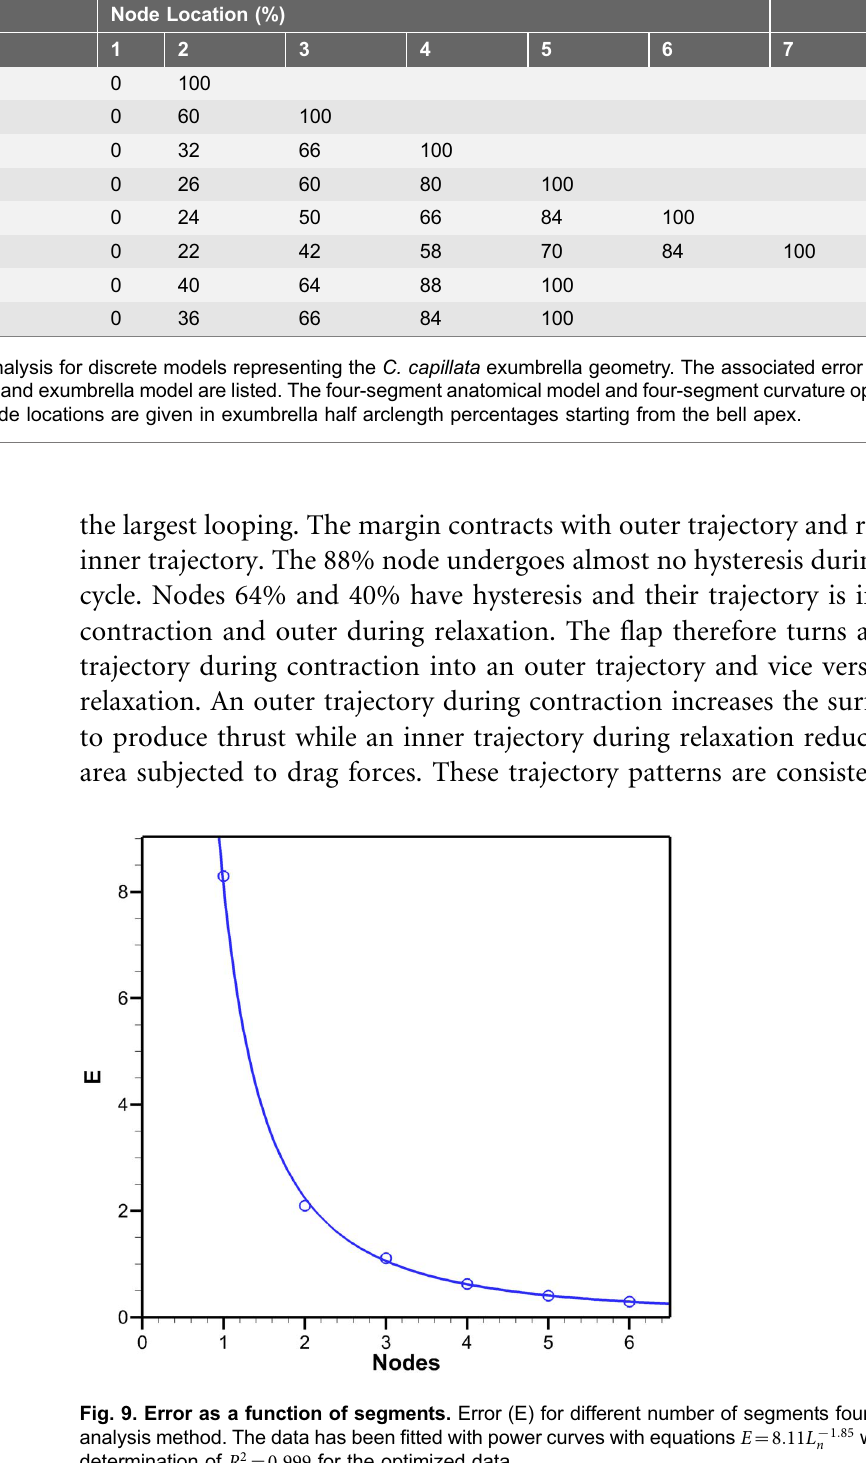
with a coefficient of n